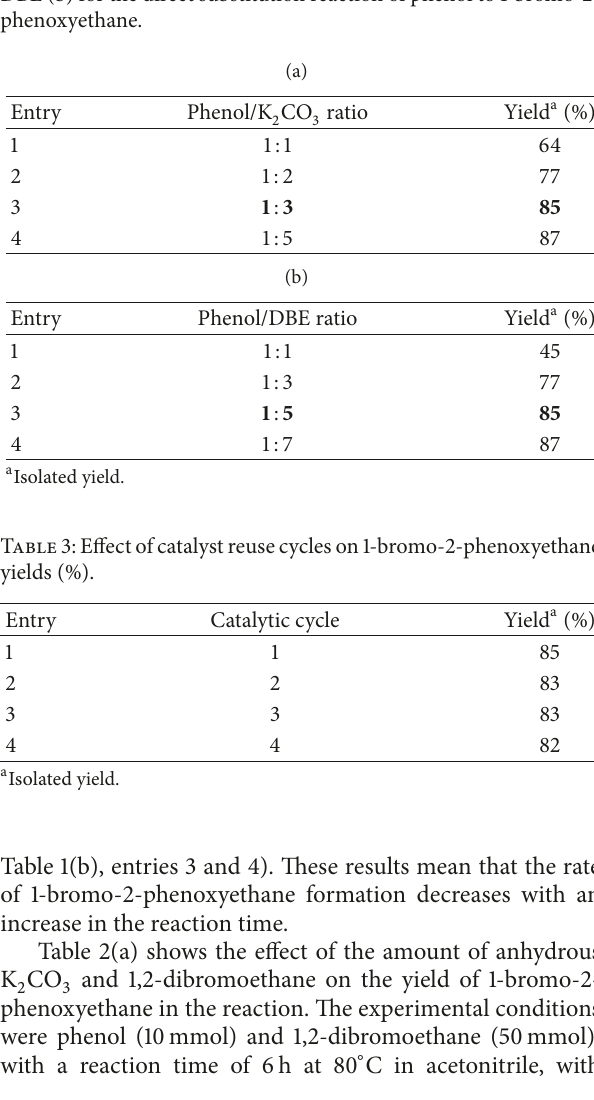
Table 2: Amounts of anhydrous K 2 CO 3 (a) and 1,2-dibromoethane- DBE (b) for the direct substitution reaction of phenol to 1-bromo-2- phenoxyethane.